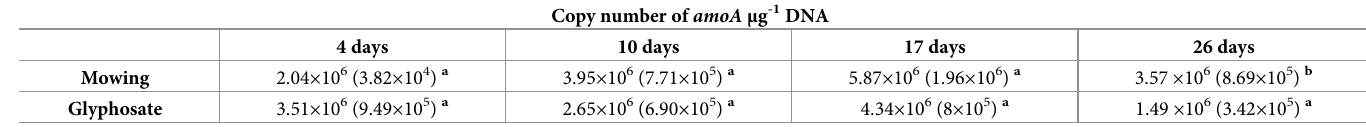
Table 6. Copy number of amoA gene of ammonia-oxidizing archaea (AOA) in the rhizosphere of glyphosate-treated or cut plants. Values between brackets indicate the standard error of the mean (n = 4). Different letters indicate statistically significant differences ( P < 0.05, two-sample